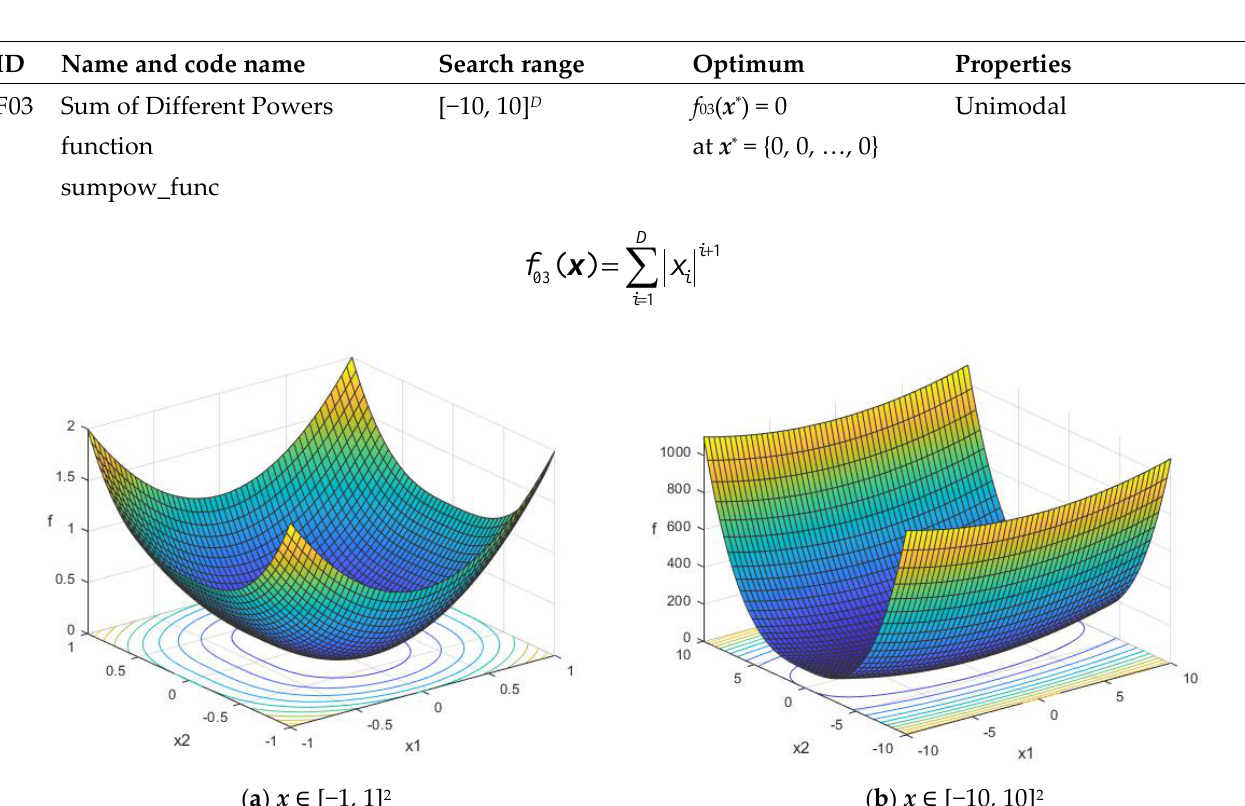
Figure A2. Ellipsoid function in two dimensions.